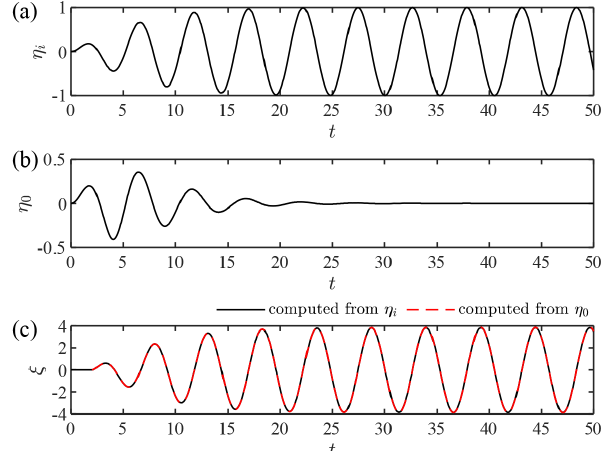
Figure 6. Kernel validation for the formation of a full standing wave ( λ = c k / 2): (a) incident wave, η i (t) ; (b) observed wave at x = 1, η 0 (t) ; and (c) shoreline elevation data computed from η i (t) and η 0 (t)